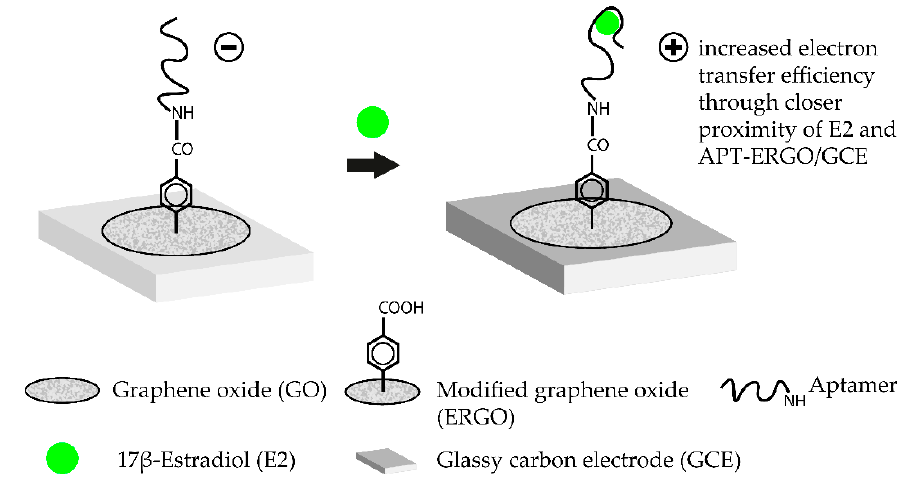
Figure 2. Working principle of a label-free aptasensor for the femtomolar detection of 17 β -estradiol (E2) using graphene oxide as an amplification platform. To immobilize the estradiol-binding aptamer, a series of previous chemical modifications are necessary. Firstly, a glassy carbon electrode (GCE) is modified with a graphene oxide (GO) layer. The GO diazonium salts are then electrochemically reduced which leads to the ERGO/GCE hybrid surface. The COOH-groups on the ERGO surface are then conjugated with NH 2 -modified E2-aptamers via carbodiimide formation. Addition of the target molecule E2 leads to the formation of the E2-aptamer complex. In the complex, E2 is brought closer to the ERGO/GCE surface which leads to an increased electron transfer efficiency. Transduction is then carried out by measuring the change in current by using square wave voltammetry. The aptasensor operates in the TISS mode. (Adapted from [45]).